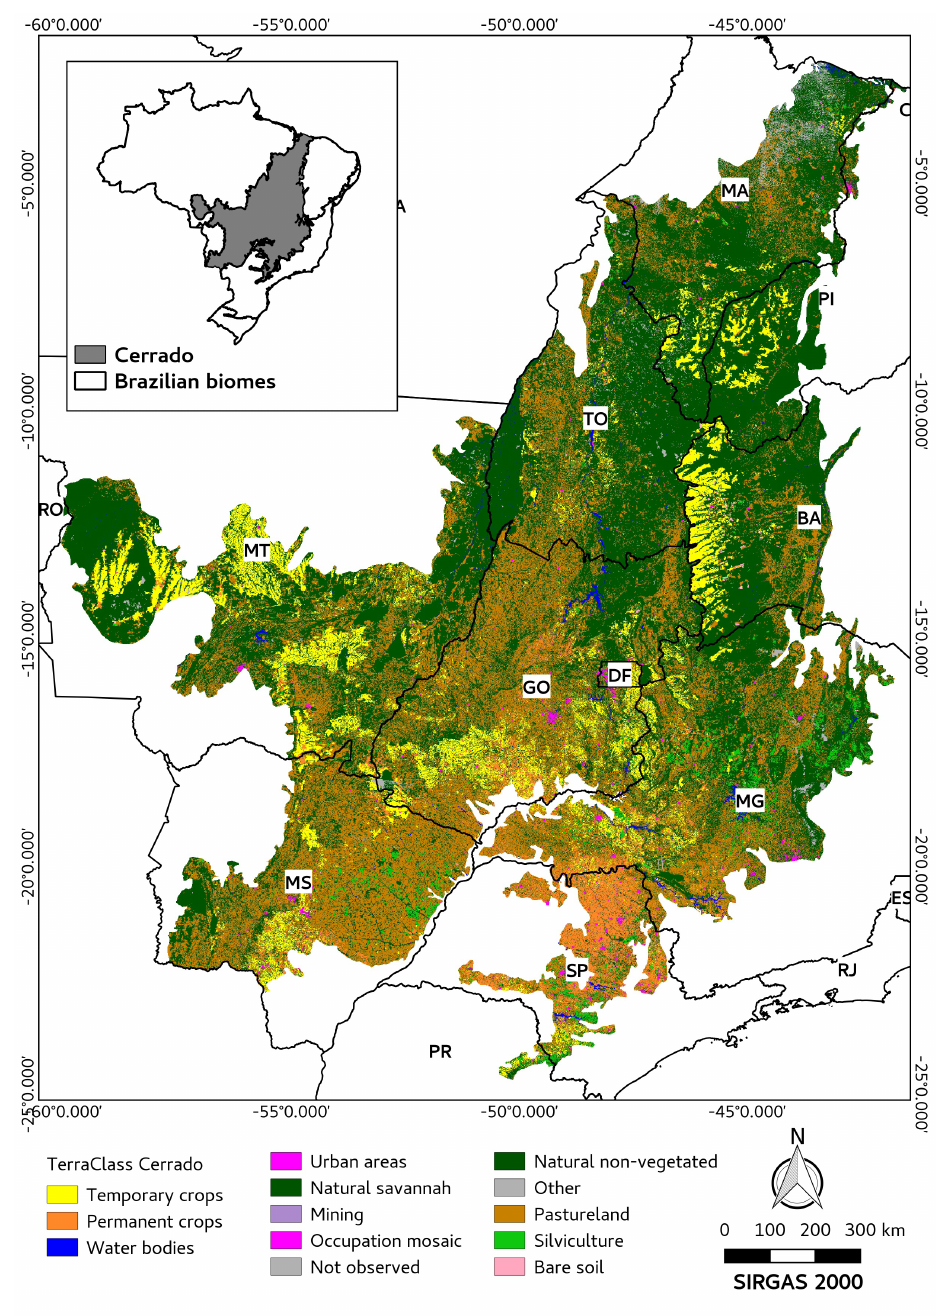
Figure 1. Relative location and 2013 land use and land cover map of the Cerrado [56]. Acronyms for Brazilian states stand for: Bahia (BA), Distrito Federal (DF), Goiás (GO) Maranhão (MA), Minas Gerais (MG), Mato Grosso do Sul (MS), Mato Grosso (MT), Paraná (PR), São Paulo (SP) and Tocantins